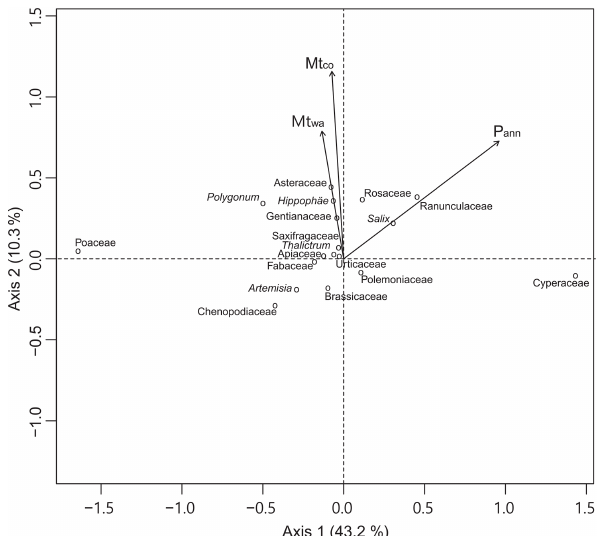
Figure 3. Plot of the first two redundancy analysis (RDA) axes showing the relationships between 18 pollen taxa (circles) and three climatic variables (arrows). P ann : mean annual precipitation (mm); Mt co : mean temperature of the coldest month ( ◦ C); and Mt wa : mean temperature of the warmest month ( ◦